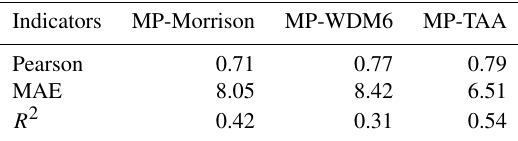
Table 3. Indicator comparison between disdrometer-derived rainfall erosivity R D and three types of WRF-derived rainfall erosivity at Chilbolton station on monthly scale (2014–2017). Indicators MP-Morrison MP-WDM6 MP-TAA Pearson 0.71 0.77 0.79 MAE 8.05 R 2